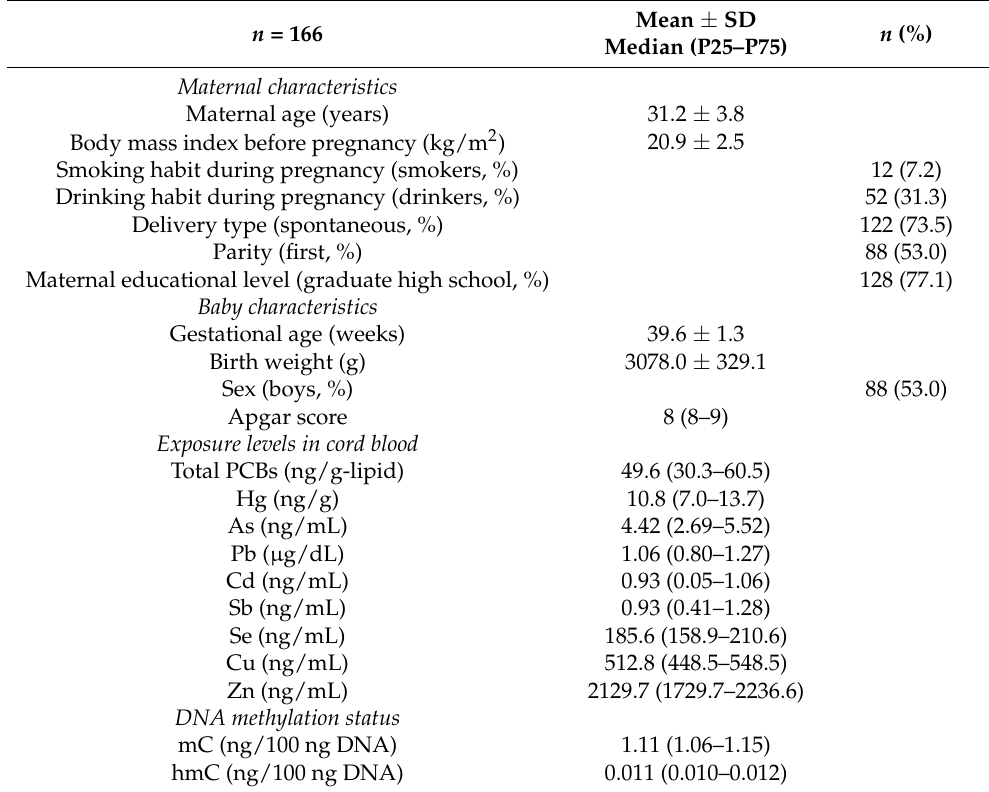
Table 1. Basal characteristics, exposure levels, and DNA methylation status in this study’s subjects.